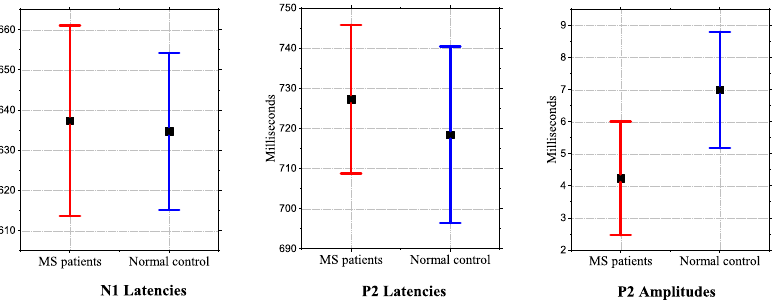
Figure 7. Comparison of the parameters of OERP components of multiple sclerosis patients and healthy controls in